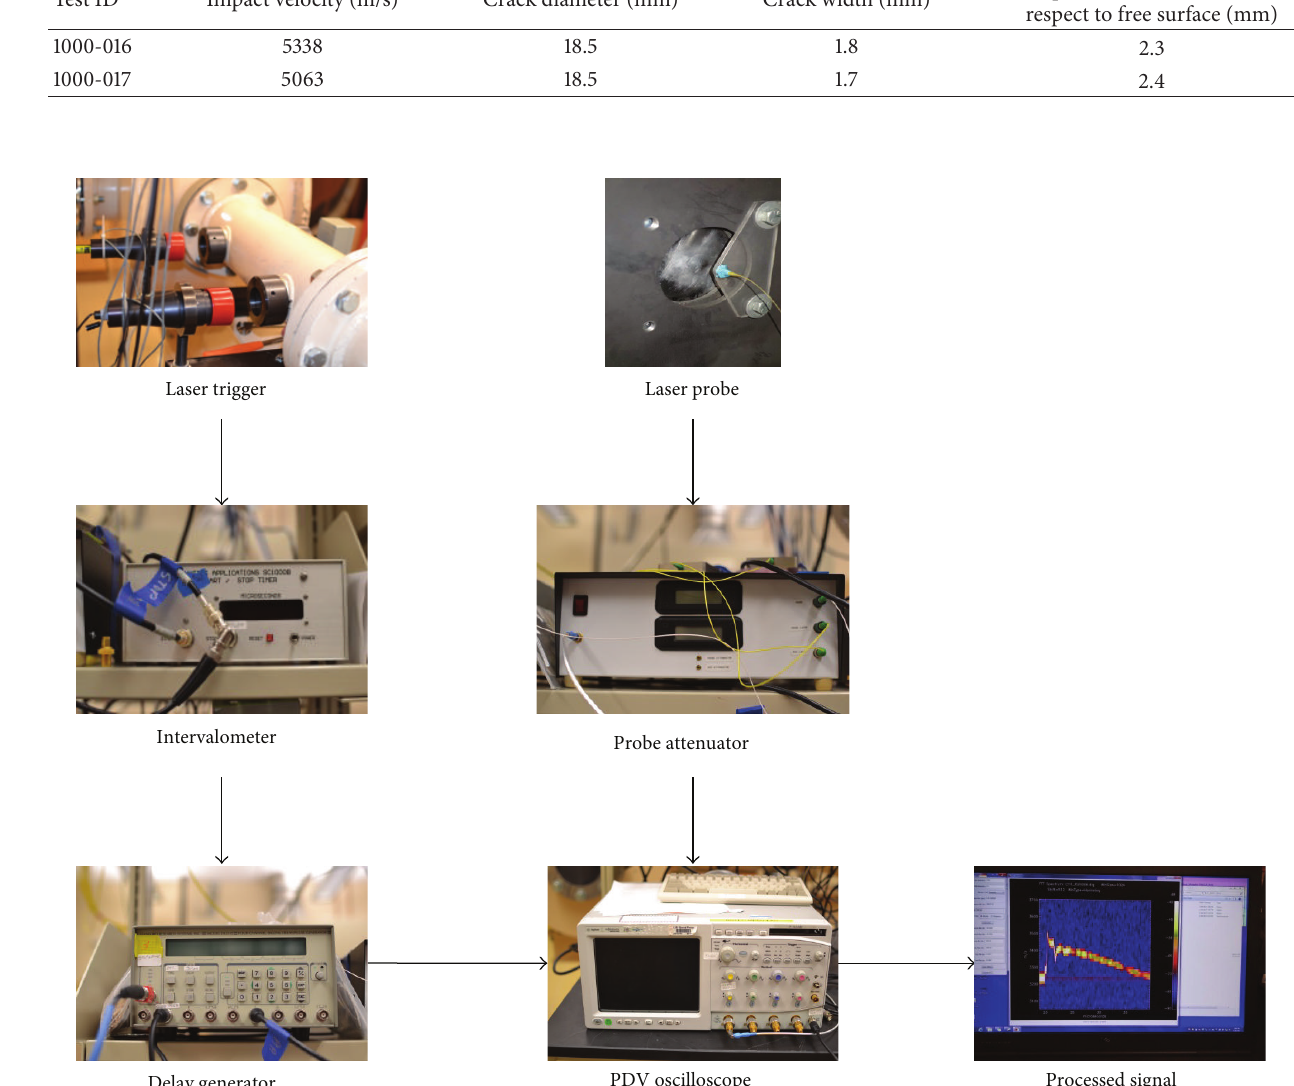
Figure 4: Layout of the PDV data acquisition.